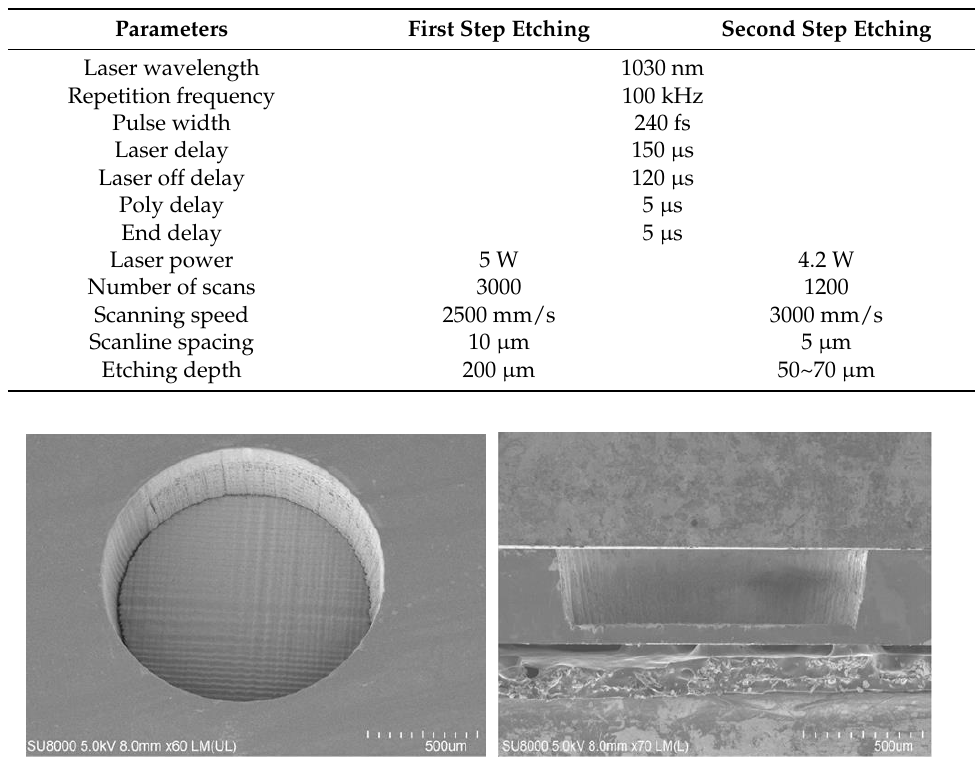
Table 1. Process parameters of femtosecond laser etching.